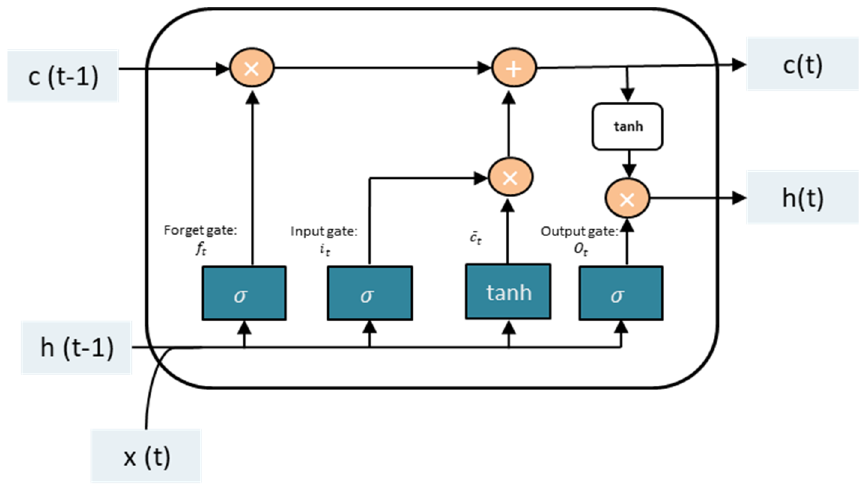
Figure 3. LSTM single cell.